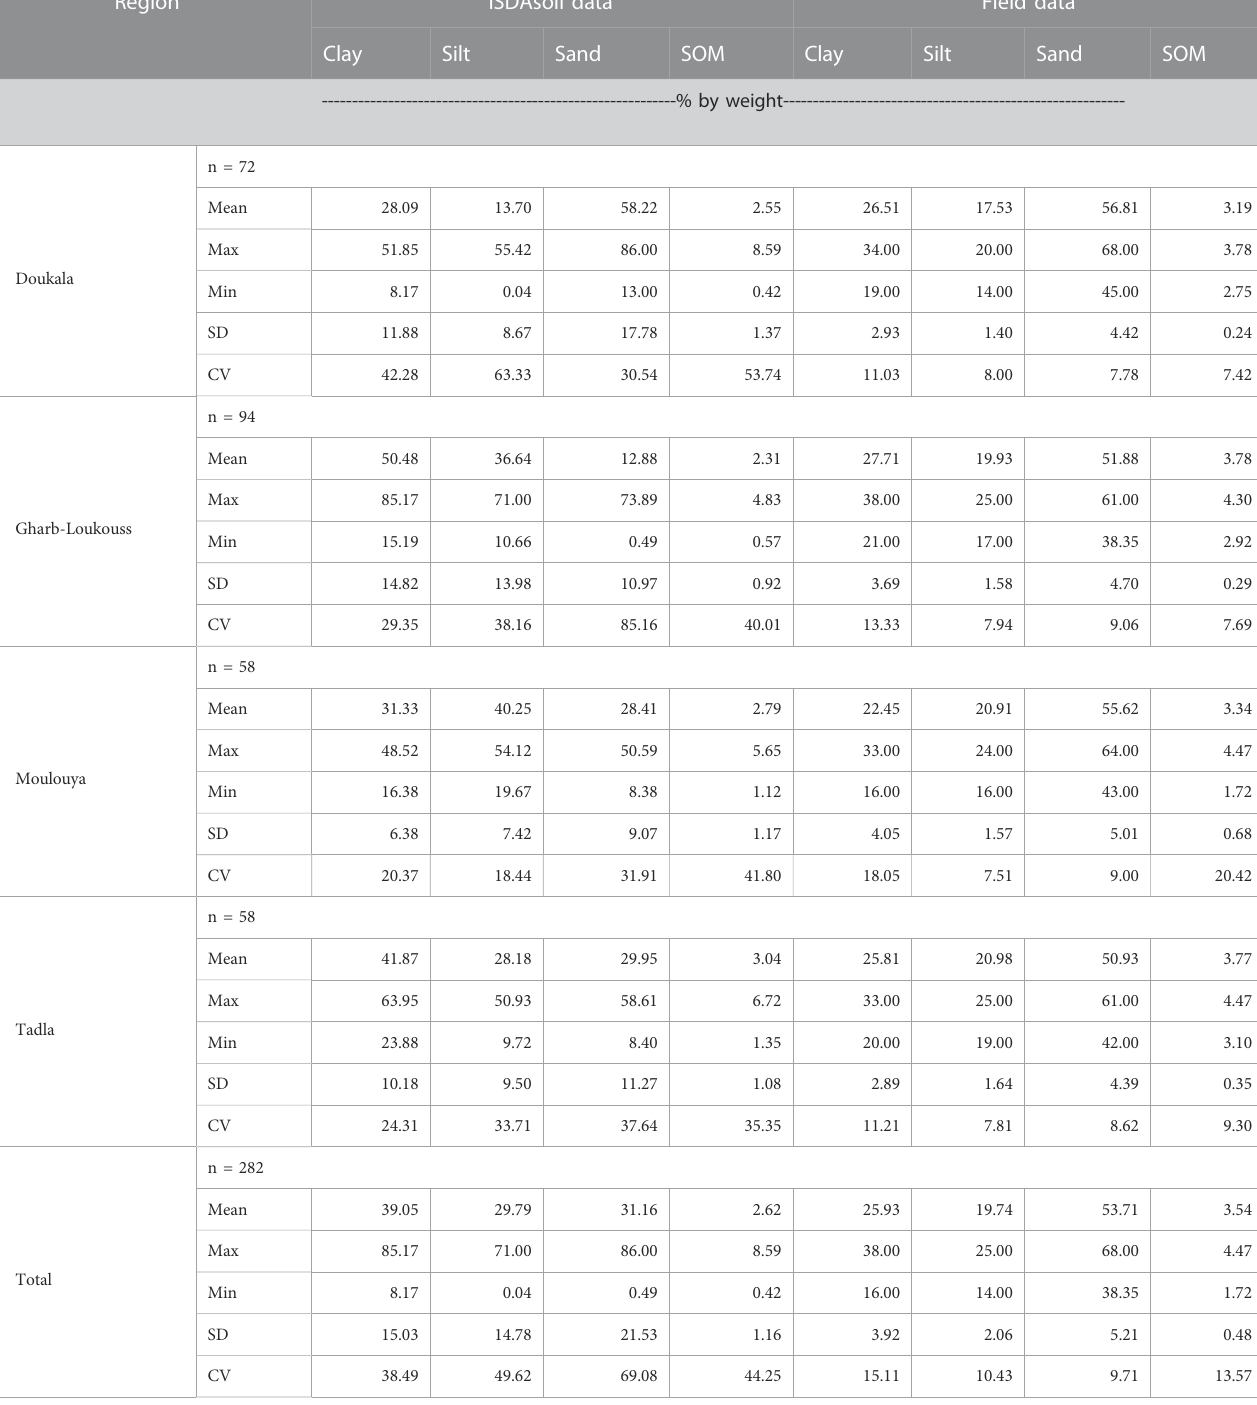
TABLE 2 Descriptive statistics of the soil sampled from four regions in Morocco (282 samples). Region iSDAsoil data Field data Clay Silt Sand SOM Clay Silt Sand